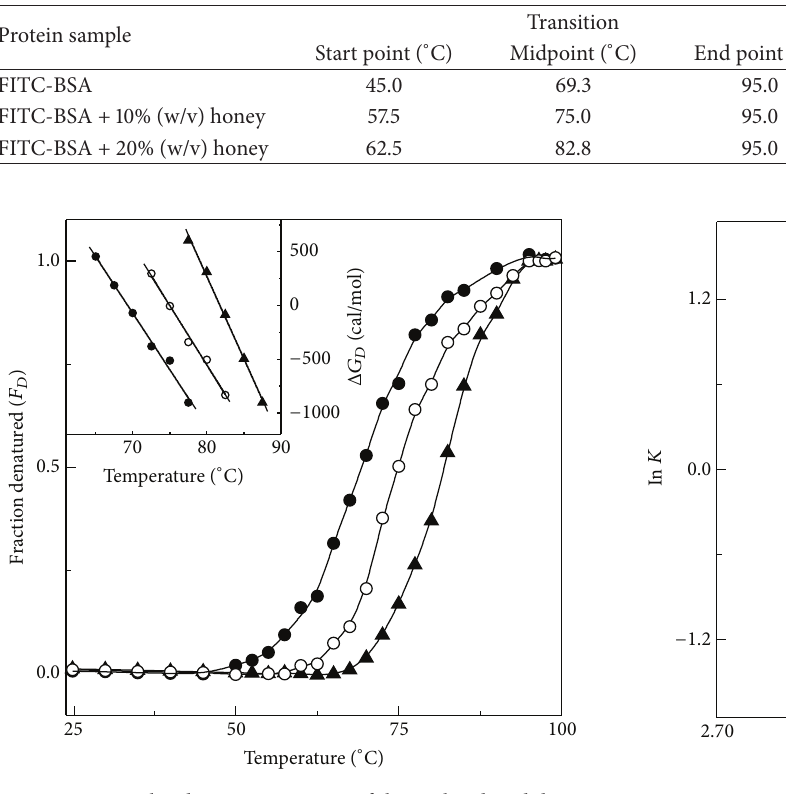
Figure 6: van’t Hoff plot of thermal denaturation results of FITC- BSA both in the absence ( e ) and presence of 10% ( I ) and 20% ( 󳵳 ) (w/v) honey, as obtained from the results shown in Figure 5.